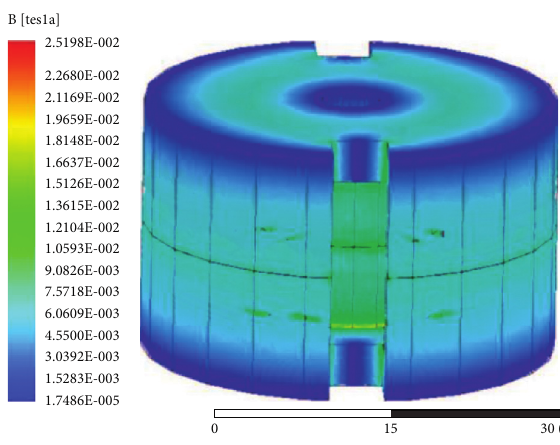
Figure 13: Core simulation with duty cycle D � 0.25.